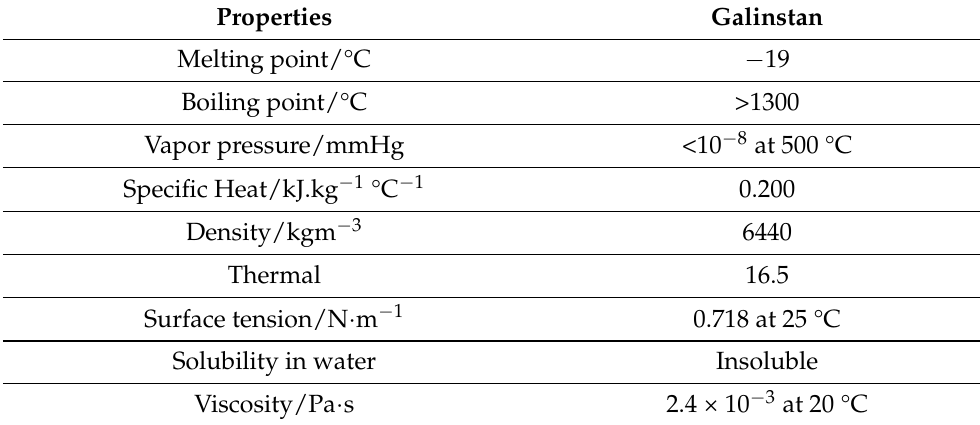
Table 2. Thermal properties of